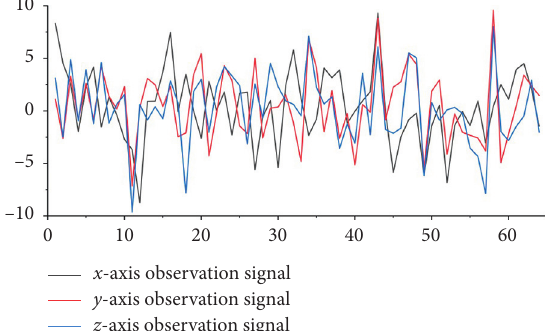
Figure 5: Observation signal matrix after sparse